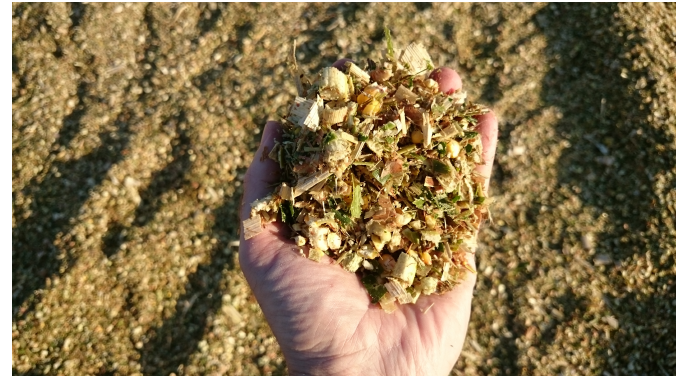
Figure 2. Example of harvested silage.